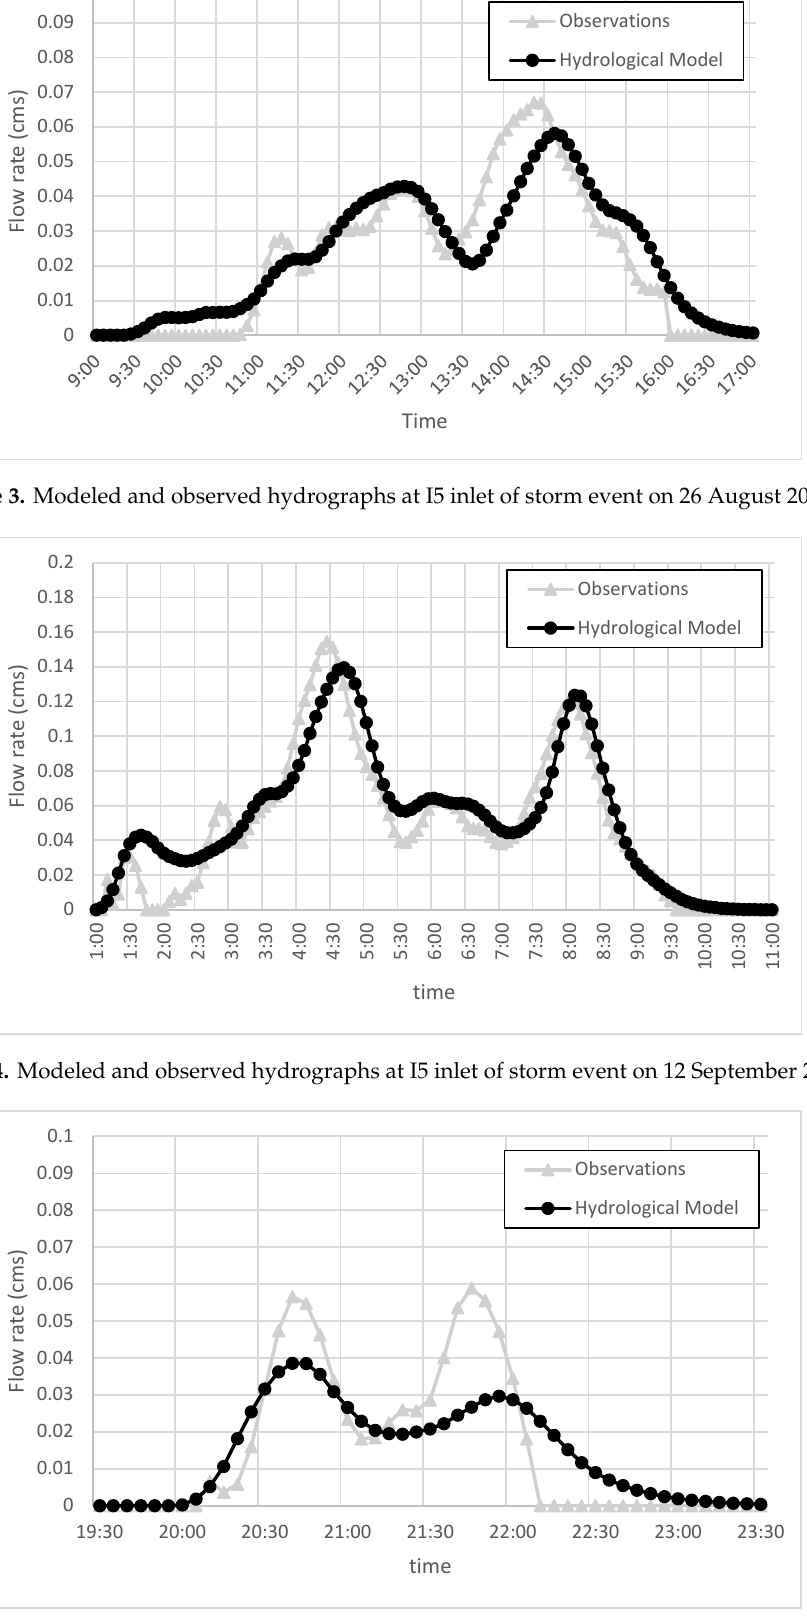
Figure 5. Modeled and observed hydrographs at I5 inlet of storm event on 20 September